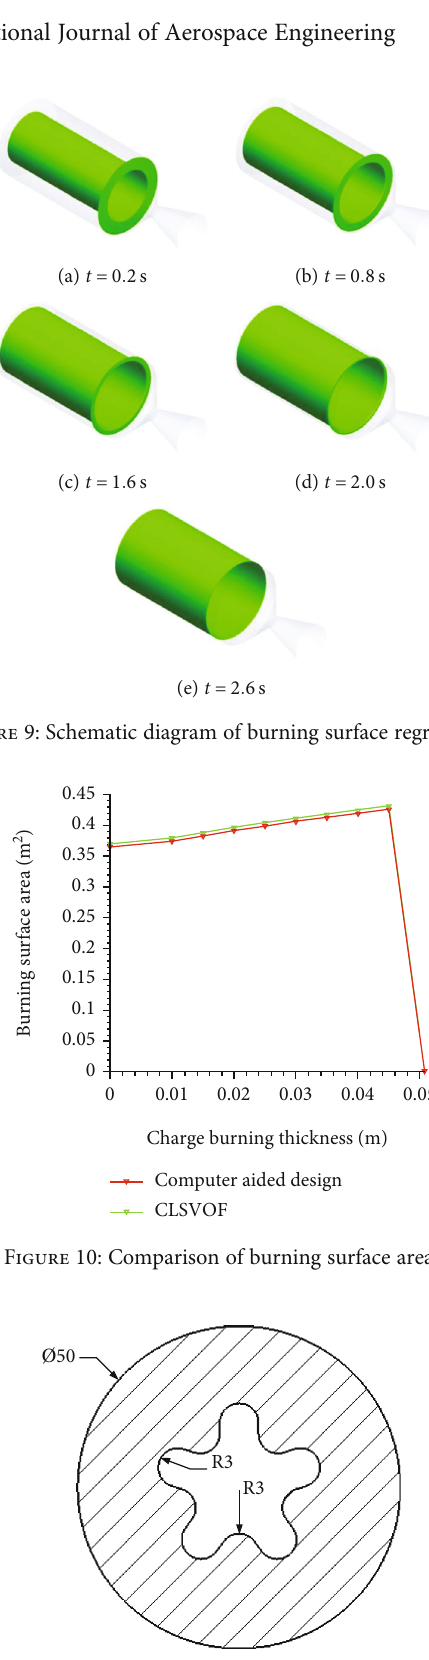
Figure 11: Cross-section of the star charge.